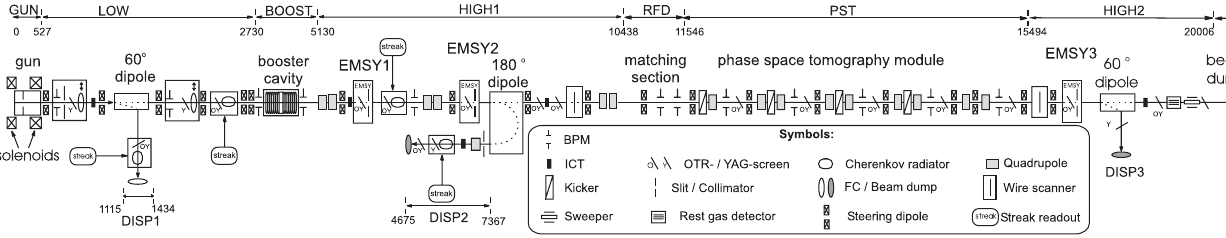
FIG. 1. Schematic diagram of the 2010–2011 PITZ electron beam line including electron gun and CDS booster cavity. Diagnostics is presented by dispersive arms (DISP1,2,3), stations with optical transition radiation and YAG screens (O/Y), and emittance measurement system stations (EMSY1,2,3). Coordinates ( z positions) with respect to (w.r.t.) the cathode plane are given in